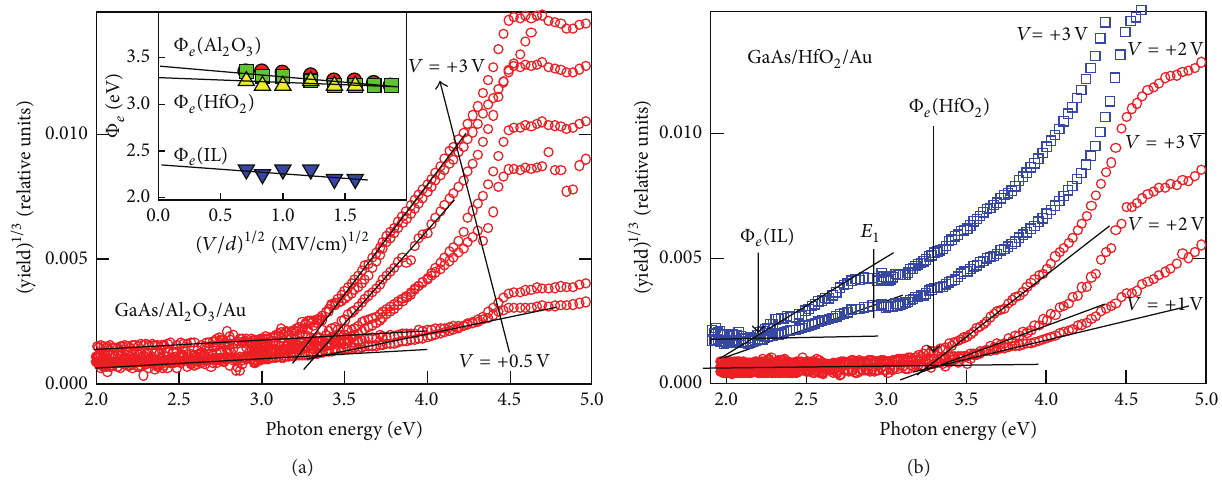
Figure 24: The 𝑌 1/3 - ℎ ] plots in samples with a-Al 2 O 3 (a) and HfO 2 (b) insulators measured under different positive voltages applied to the top Au electrode used to determine the electron IPE spectral thresholds. The inset in panel (a) shows the Schottky plot of the thresholds of electron IPE from the GaAs VB into the CB of Al 2 O 3 ( I , ◻ ) and HfO 2 ( △ ) and into the IL ( 󳶋 ). Vertical arrows mark the observed threshold energies and lines guide the eye.